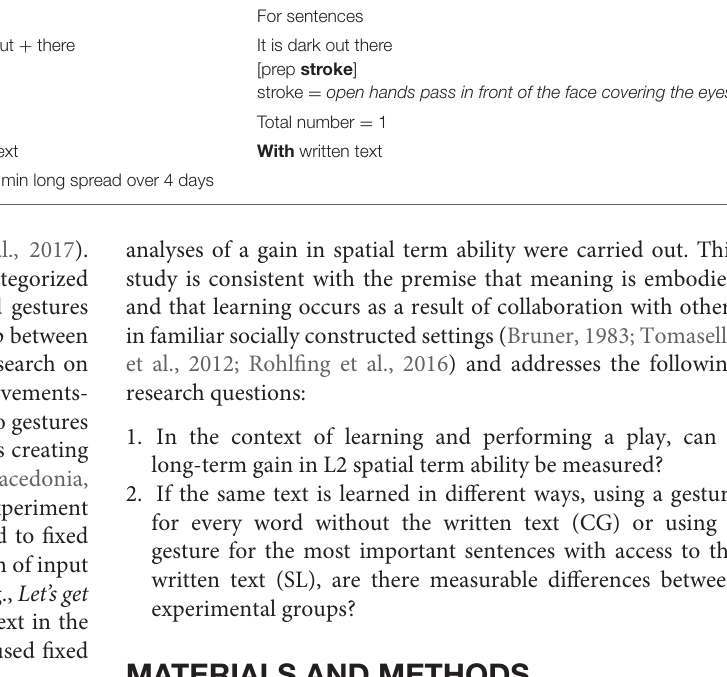
TABLE 2 | Summary of experimental conditions. Codified gesture condition Scenic learning